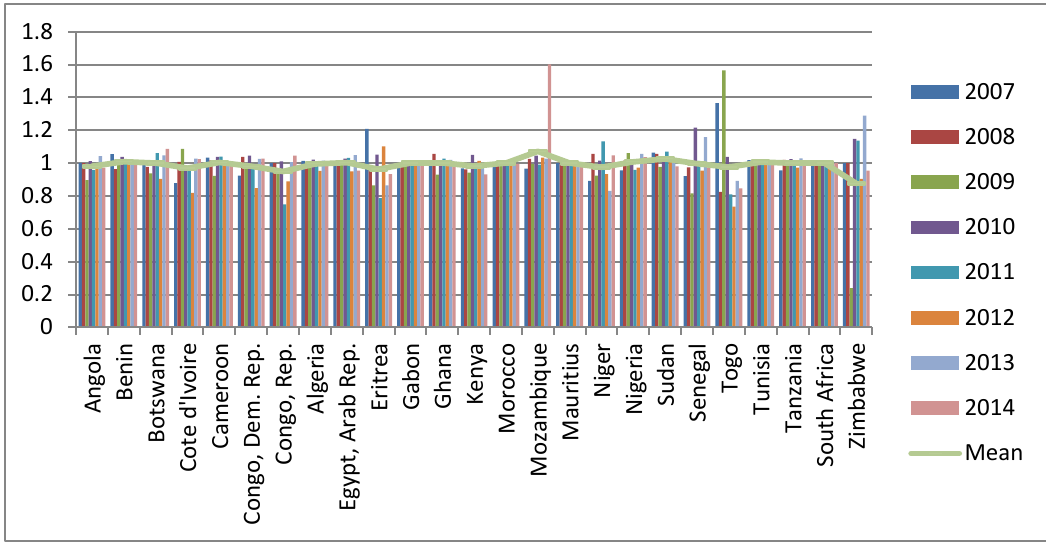
Figure 7. Comparison between average MPI energy e ffi ciency with and without CO 2 emissions.